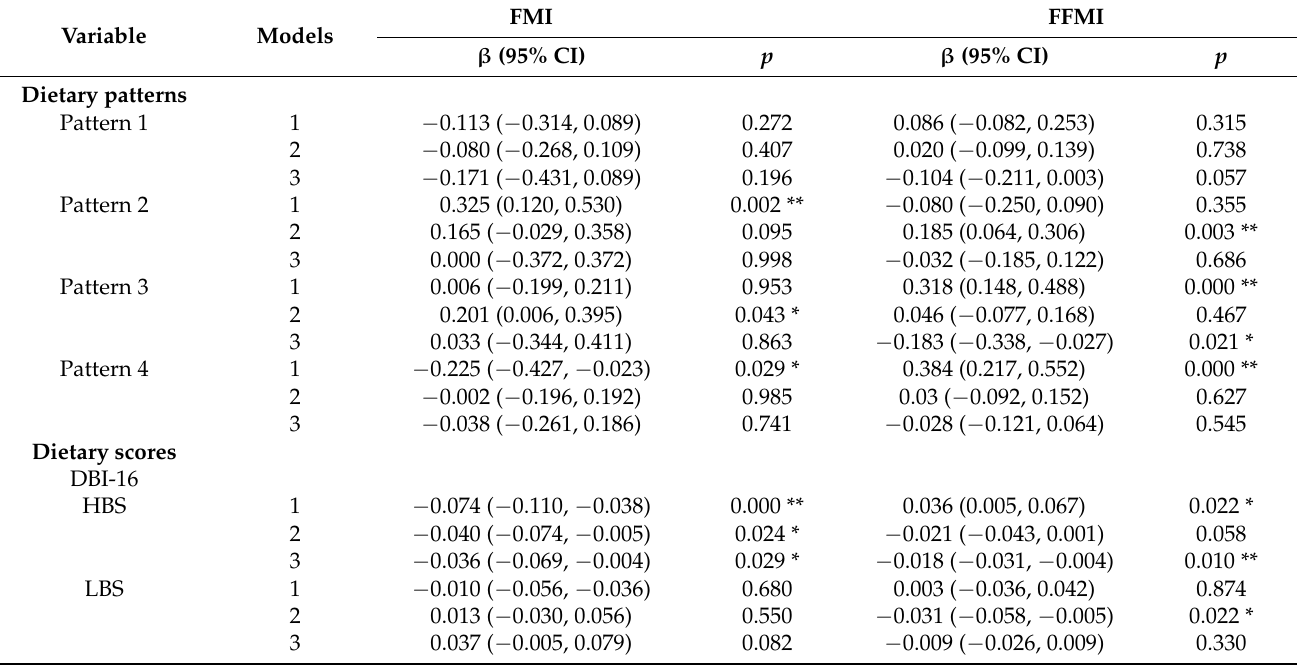
Table 6. The association of dietary scores and dietary patterns with FMI and